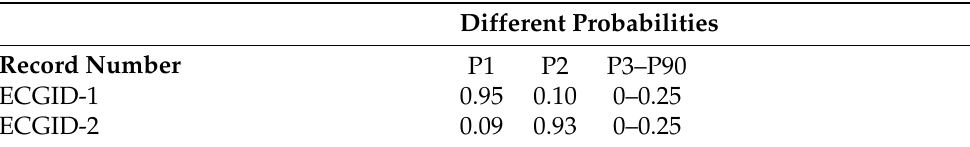
Table 8. Individual probabilities for testing records 1 and 2.